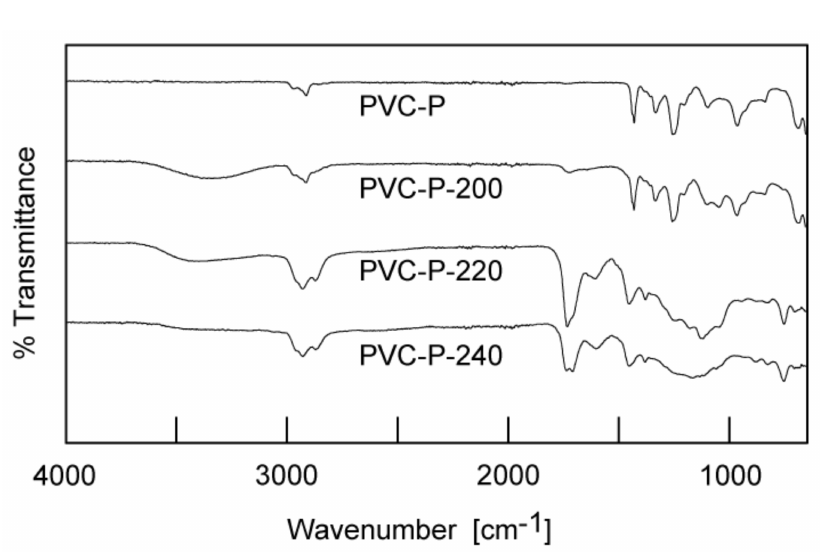
Figure 4. FT-IR spectrum of PVC − P and that pyrolyzed at 200 ◦ C (PVC − P − 200), 220 ◦ C (PVC − P − 220), and 240 ◦ C (PVC − P − 240); PVC/glycerol mass ratio = 2/3, reaction time = 120